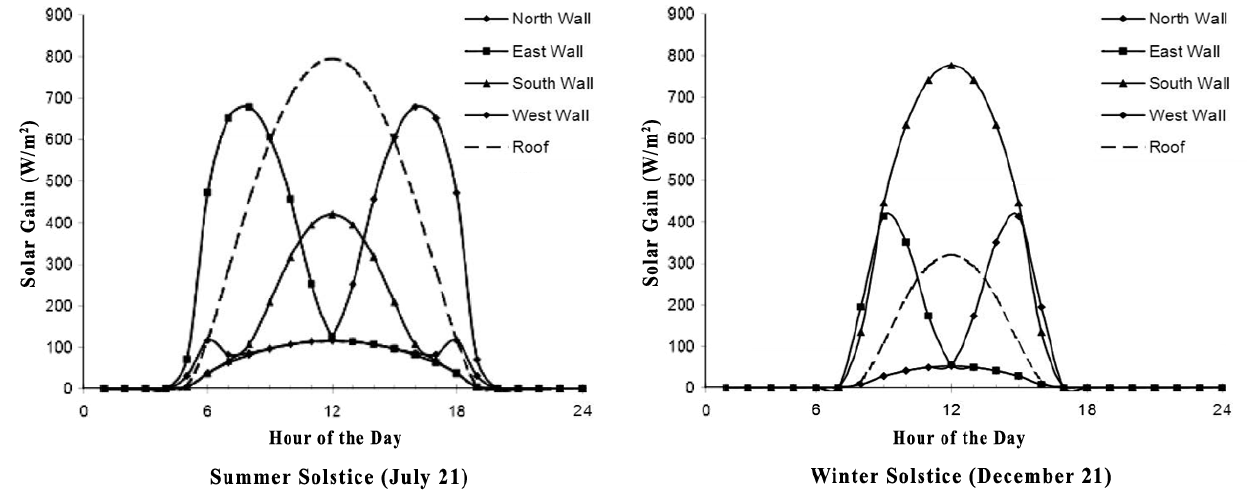
Figure 6. Clear sky solar gain on wall surfaces at 45° latitude